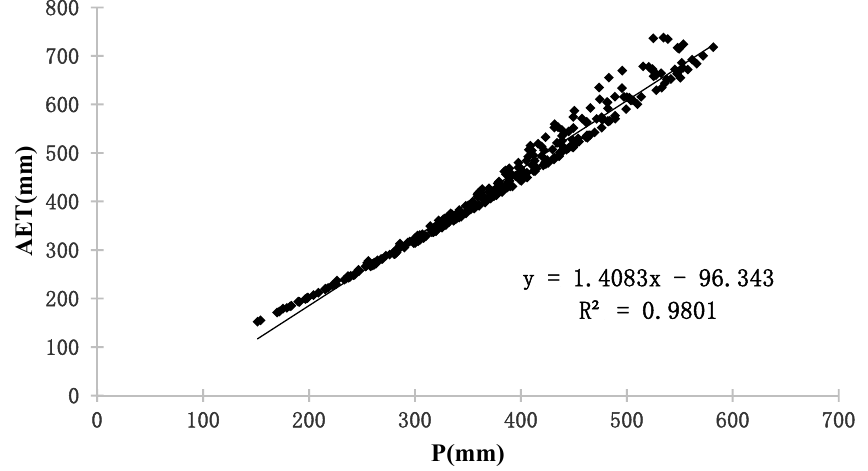
Figure 11. Fitting analysis of actual evapotranspiration and precipitation scattered points in the YRB.